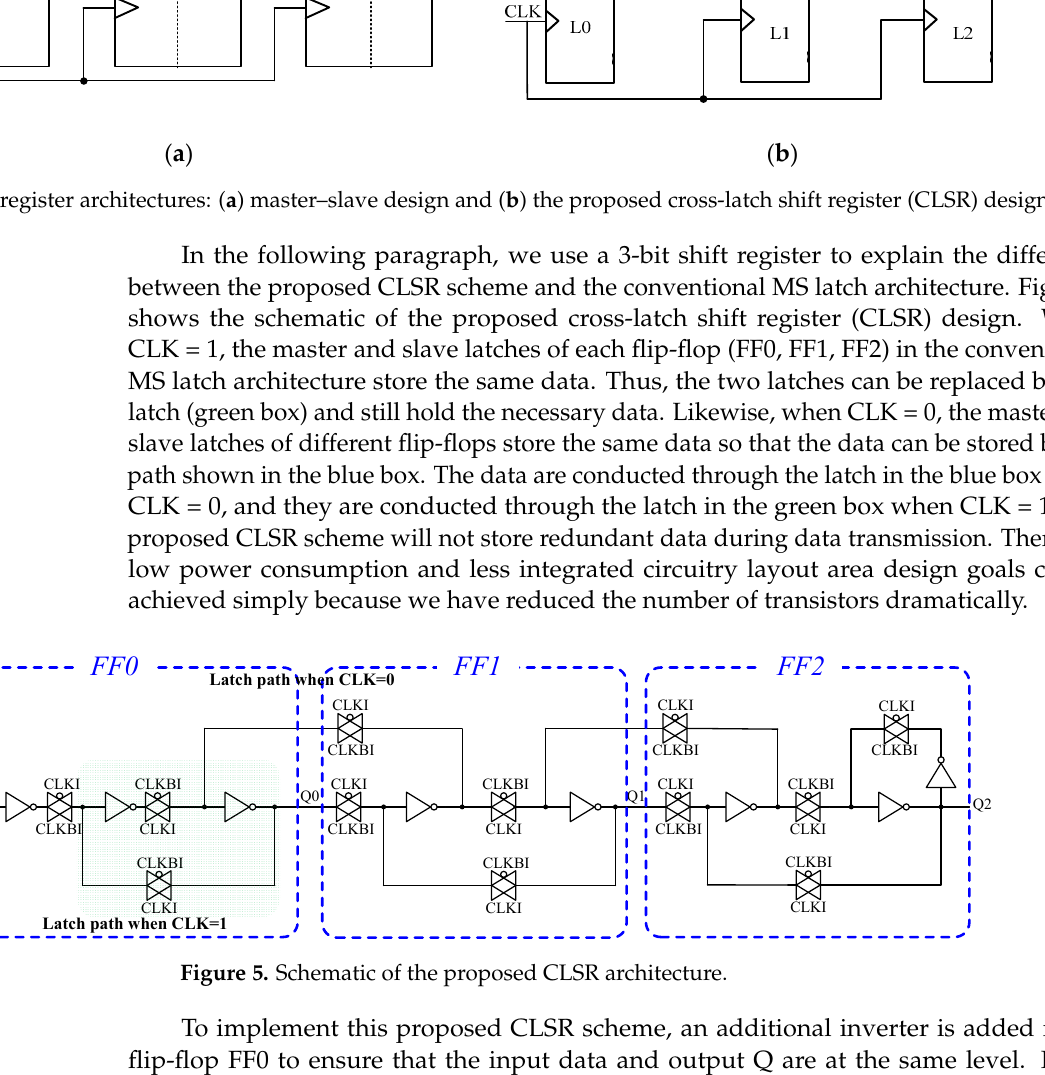
Figure 5. Schematic of the proposed CLSR architecture.